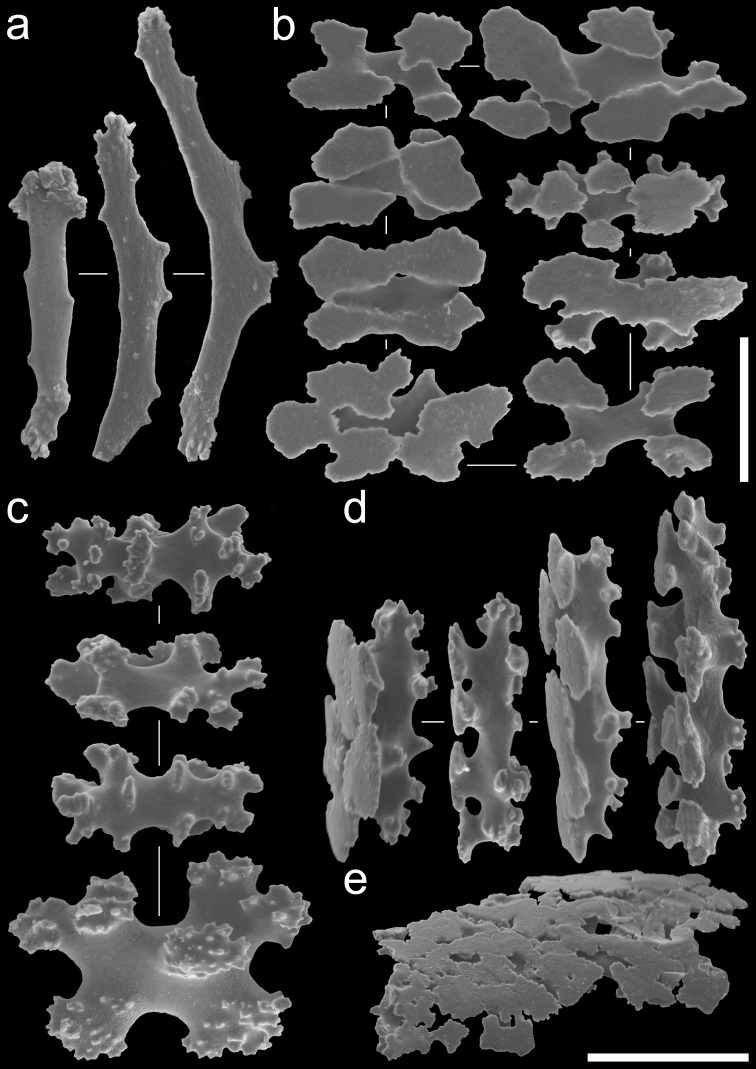
Sclerite types observed in Bunga
payung gen. nov. et sp. nov., NSMT-Co 1679, holotype: a Anthocodial rods b table-radiates of calyx, top view c table-radiates of calyx, bottom view d table-radiates of calyx, lateral view e fragment of fused table-radiates of the stolon. Scale bars: 0.05 mm (a–d); 0.1 mm (e).